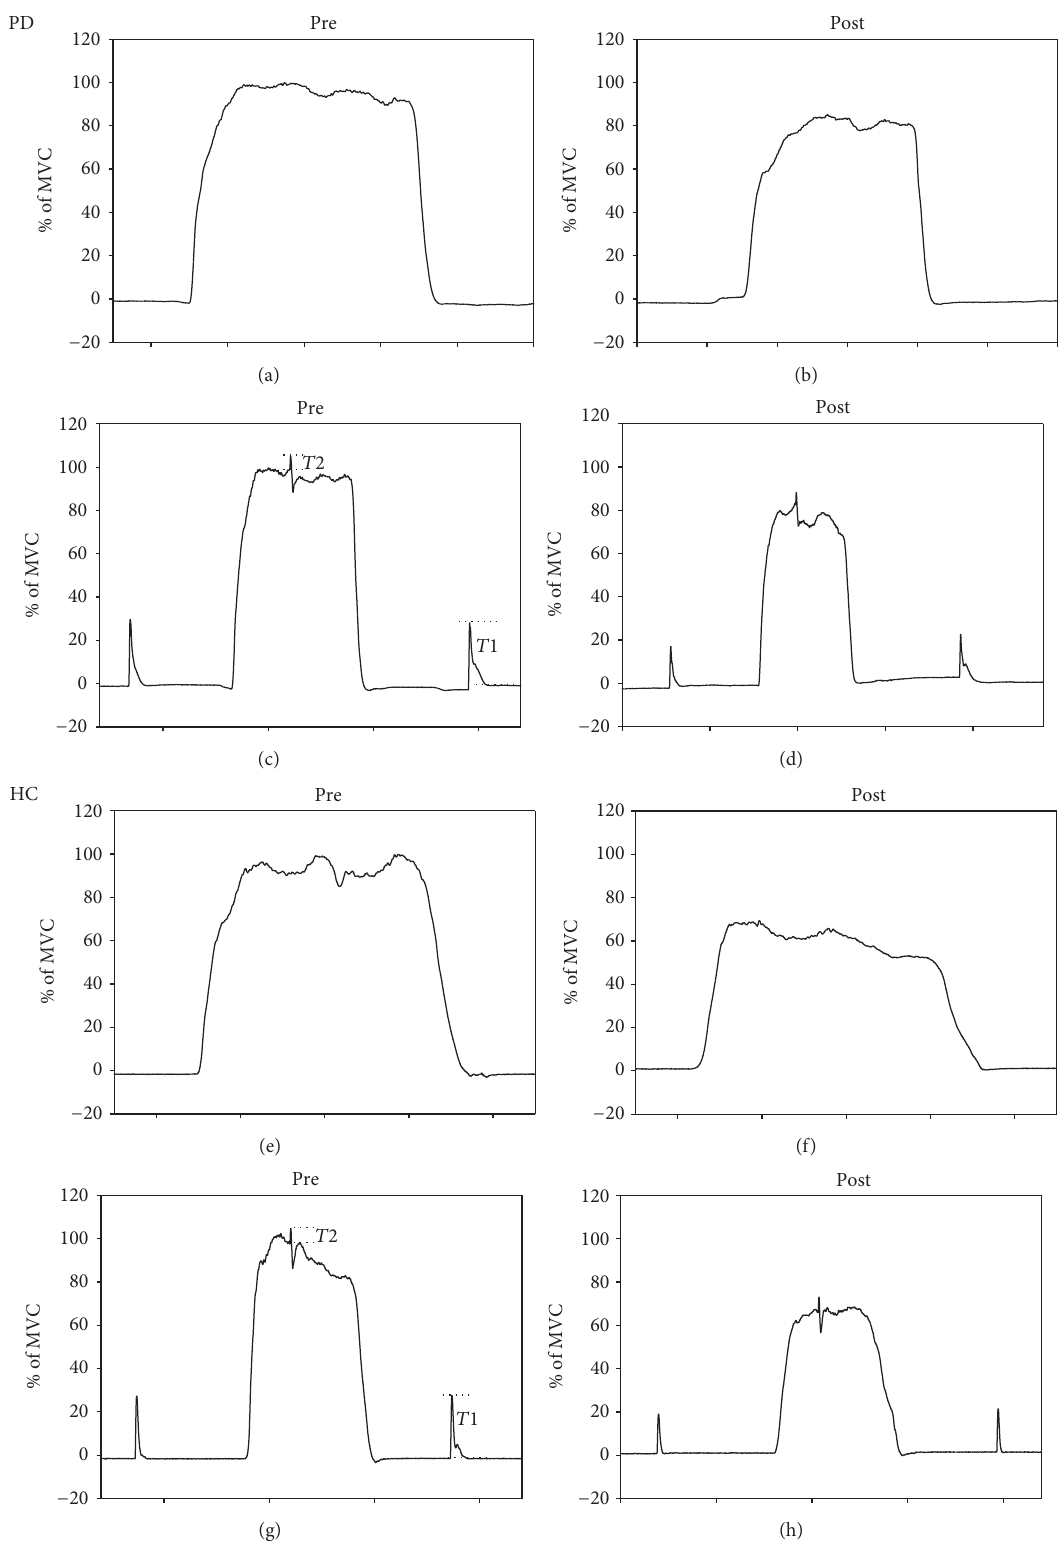
Figure 1: Representative force-time curves of MVC, twitch force, and interpolated twitch for one PD patient ((a)–(d)) and one healthy subject ((e)–(h)) before (pre) and after (post) fatigue. The 𝑦 -axis shows the percentage of the peak MVC, with the prefatigue maximum set to 100%. 𝑇 1 : potentiated twitch was also used to represent twitch